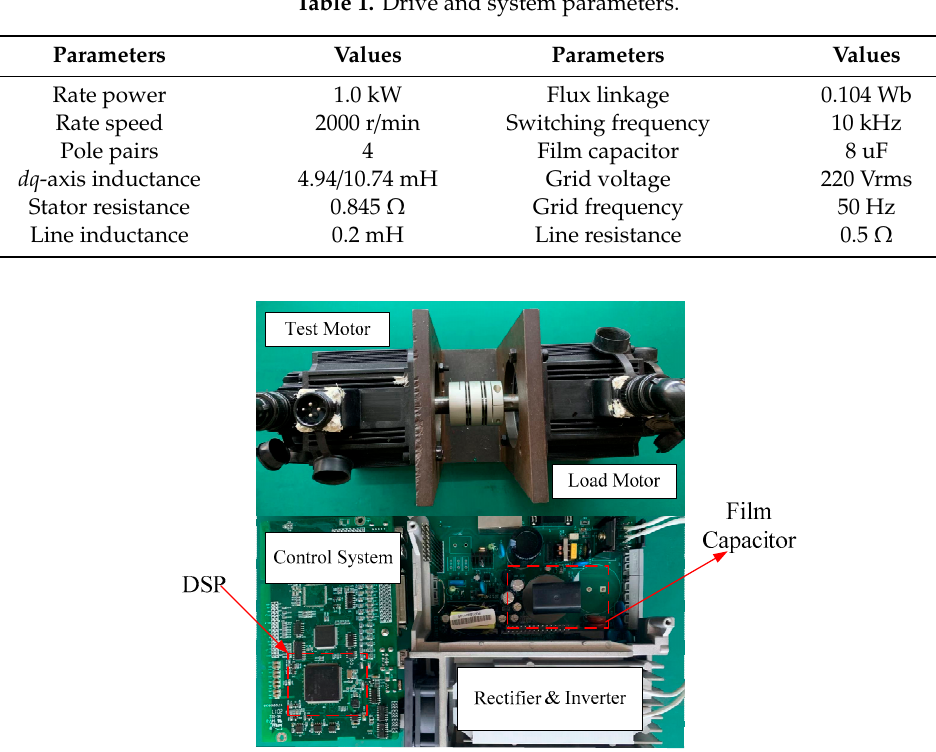
Figure 14. Experiment hardware configuration.